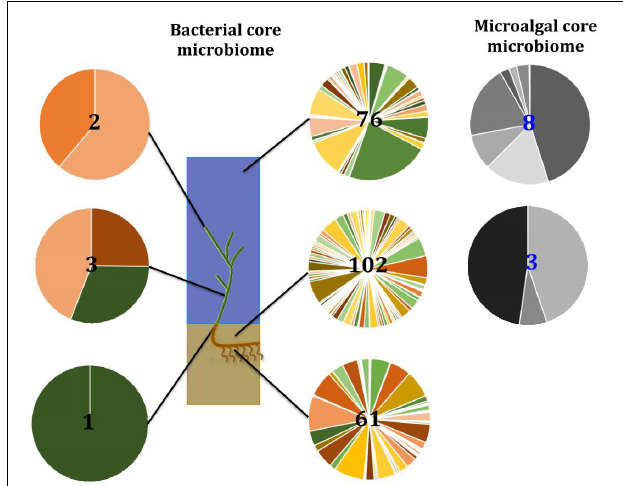
FIGURE 13 | Ecological dynamics of the seagrass microbiomes. Distinct microbial communities live in association with disparate sections of the plant (i.e., upper leaf, lower leaf, sheath, and roots and rhizomes) and its surroundings (i.e., surficial sediment and adjacent seawater). Their composition and structure are strongly shaped by the varying conditions offered within each microenvironment and also influenced by the environment. Therefore, specific bacterial (full color) and microalgal (gray) members make up core microbiomes that are different from each other and constitute up to 4% of the entire microbiome. This variability at the microscale is well conserved within each site, and despite the biogeographical changes of microbial communities, there are some microorganisms that consistently occur within microenvironment types. Numbers in the middle represent total number of core